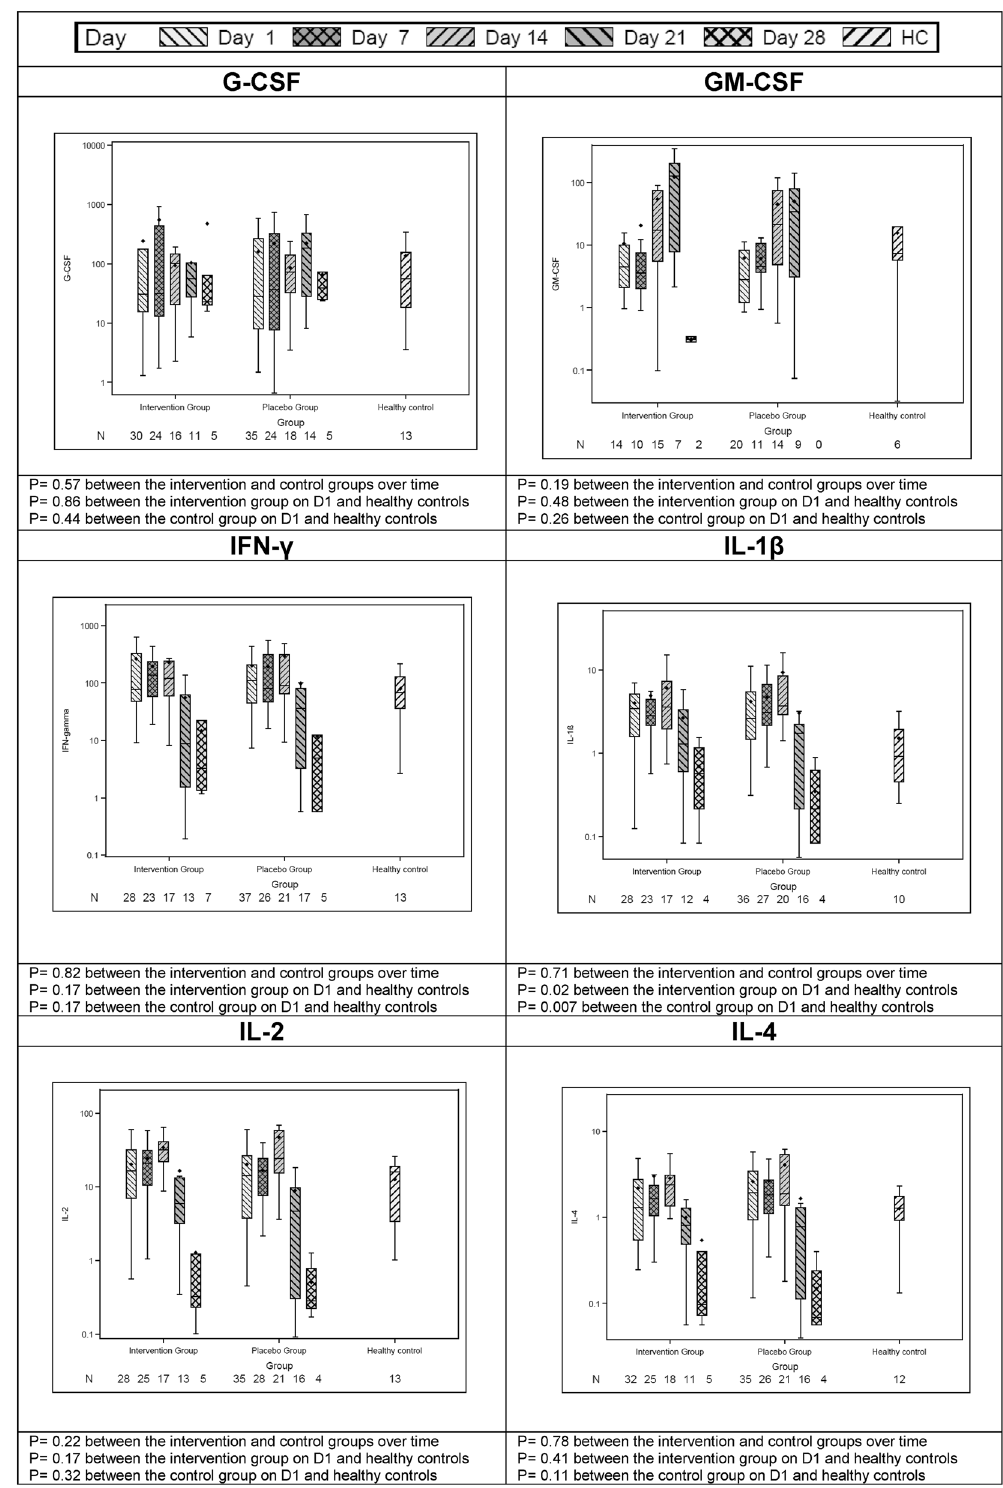
Figure 1. Serial measurements of selected plasma cytokine concentrations in patients treated with interferon- β1b and lopinavir–ritonavir, patients treated with placebo and healthy control. All cytokine levels were calculated based on mean fluorescent intensity and reported in pg/mL. We compared serial cytokine levels between patients treated with interferon-β1b and lopinavir–ritonavir and patients treated with placebo using a mixed linear model. We compared D1 values in both groups with those of healthy control using Mann–Whitney U test. G-CSF: granulocyte-colony stimulating factor; GM-CSF: granulocyte–macrophage colony-stimulating factor; IFN: interferon; IL: